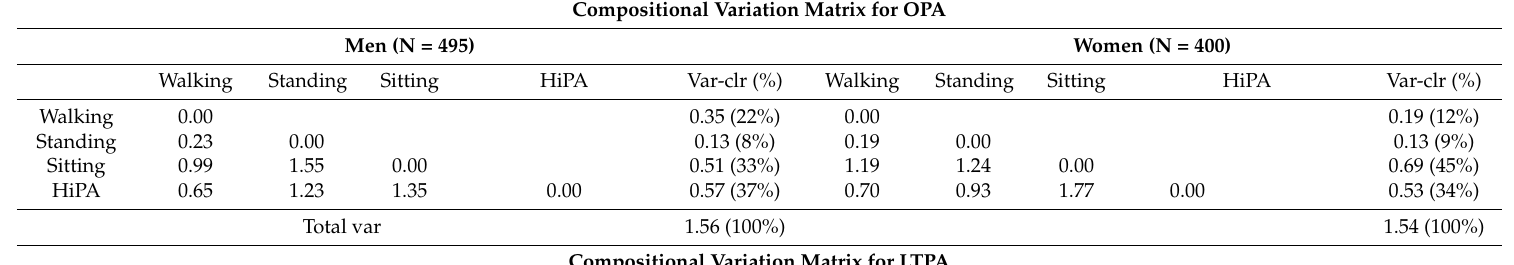
Compositional Variation Matrix for LTPA Men (N = 495) Women (N = 400) SB Walking Standing HiPA TIB Var-clr (%) SB Walking Standing HiPA TIB Var-clr (%)